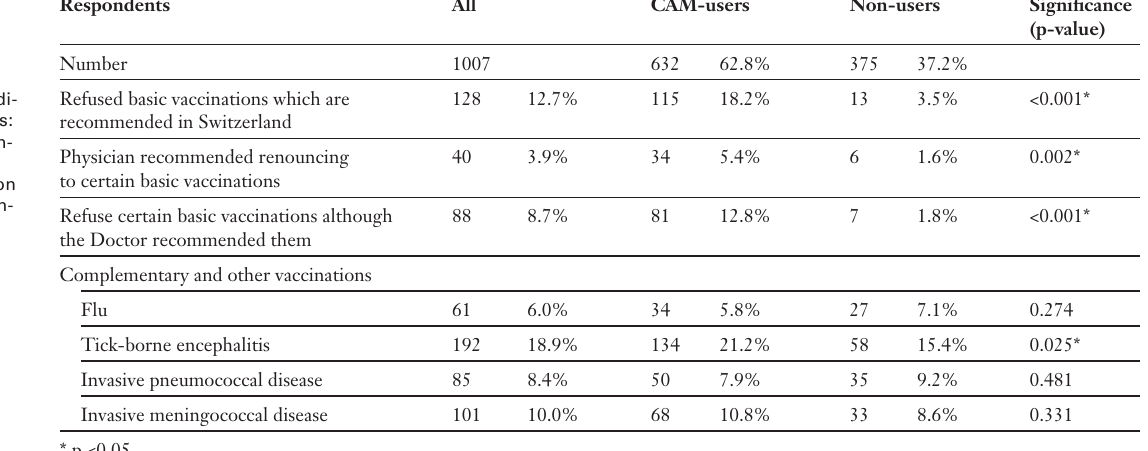
Physicians’ attitude towards CAM and rate of vaccine-re- fusal by the corre- sponding patients. Data on the physi- cians’ attitude are derived exclusively from information given by the respon- dents. The ratio be- tween the number of respondents refusing some basic vaccines and of those using CAM is shown (%-value). The rate of parents’ choice for vaccination refuse despite physicians’ recommendation is shown as well